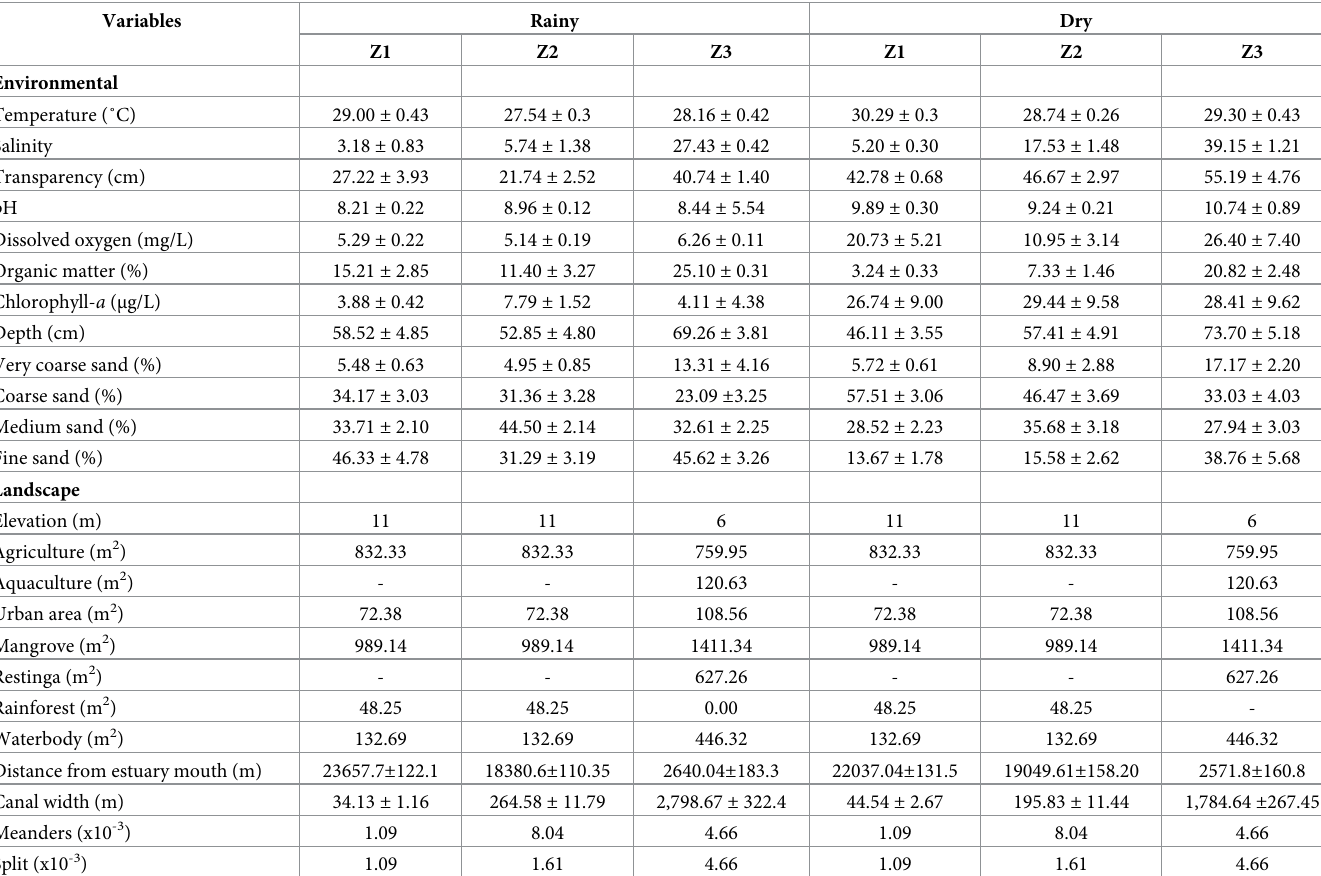
Table 1. Mean variations in the environmental and landscape variables ( ± SE) for the study period in the Mamanguape River estuary. (Z1 = zone 1; Z2 = zone 2; Z3 = zone 3).